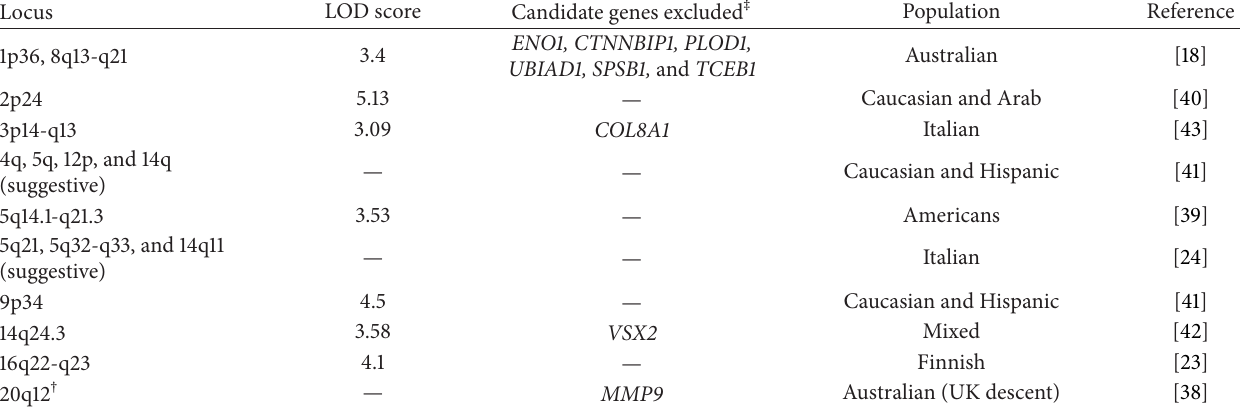
Table 1: Loci identified in keratoconus patients by linkage analysis and identity-by-descent approach.